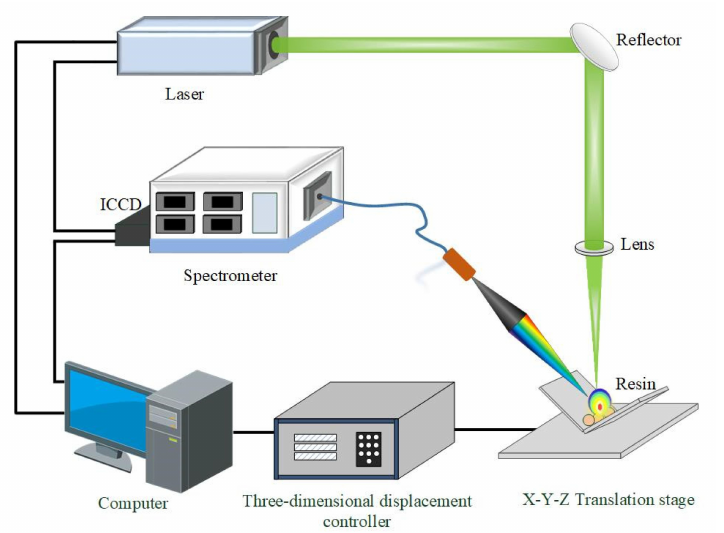
Figure 1. Schematic diagram of laser-induced breakdown spectroscopy